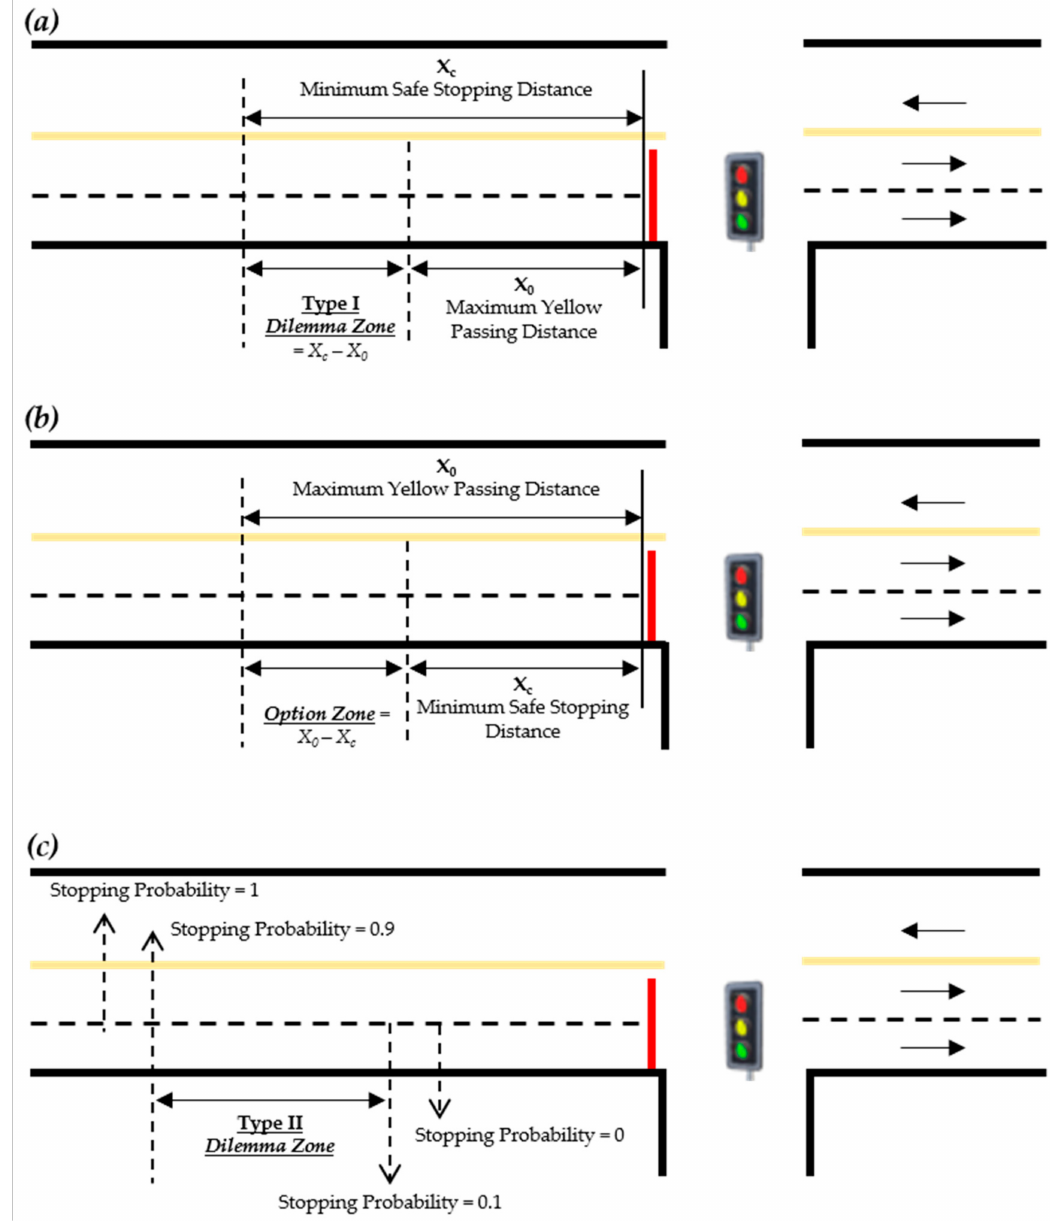
Figure 1. Types of dilemma zone: ( a ) Type I dilemma zone, ( b ) Option zone, ( c ) Type II dilemma